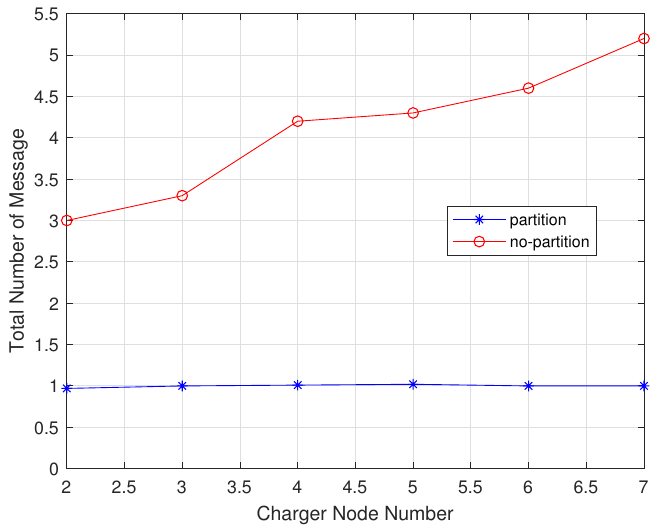
Figure 21. Total message number varies with charger